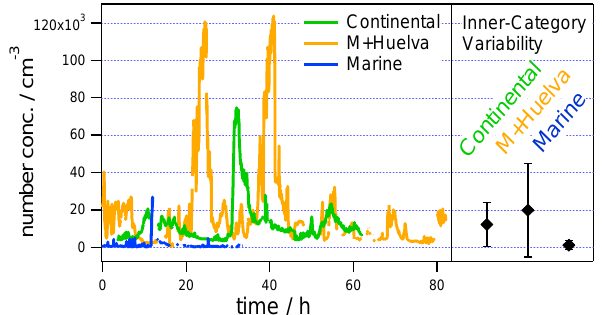
Fig. 11. Time series of the number concentration (CPC) for three different air masses (“Continental”, “Marine+Huelva” and “Marine”) and corresponding inner-category variability determined based on the relative standard deviations of the measured